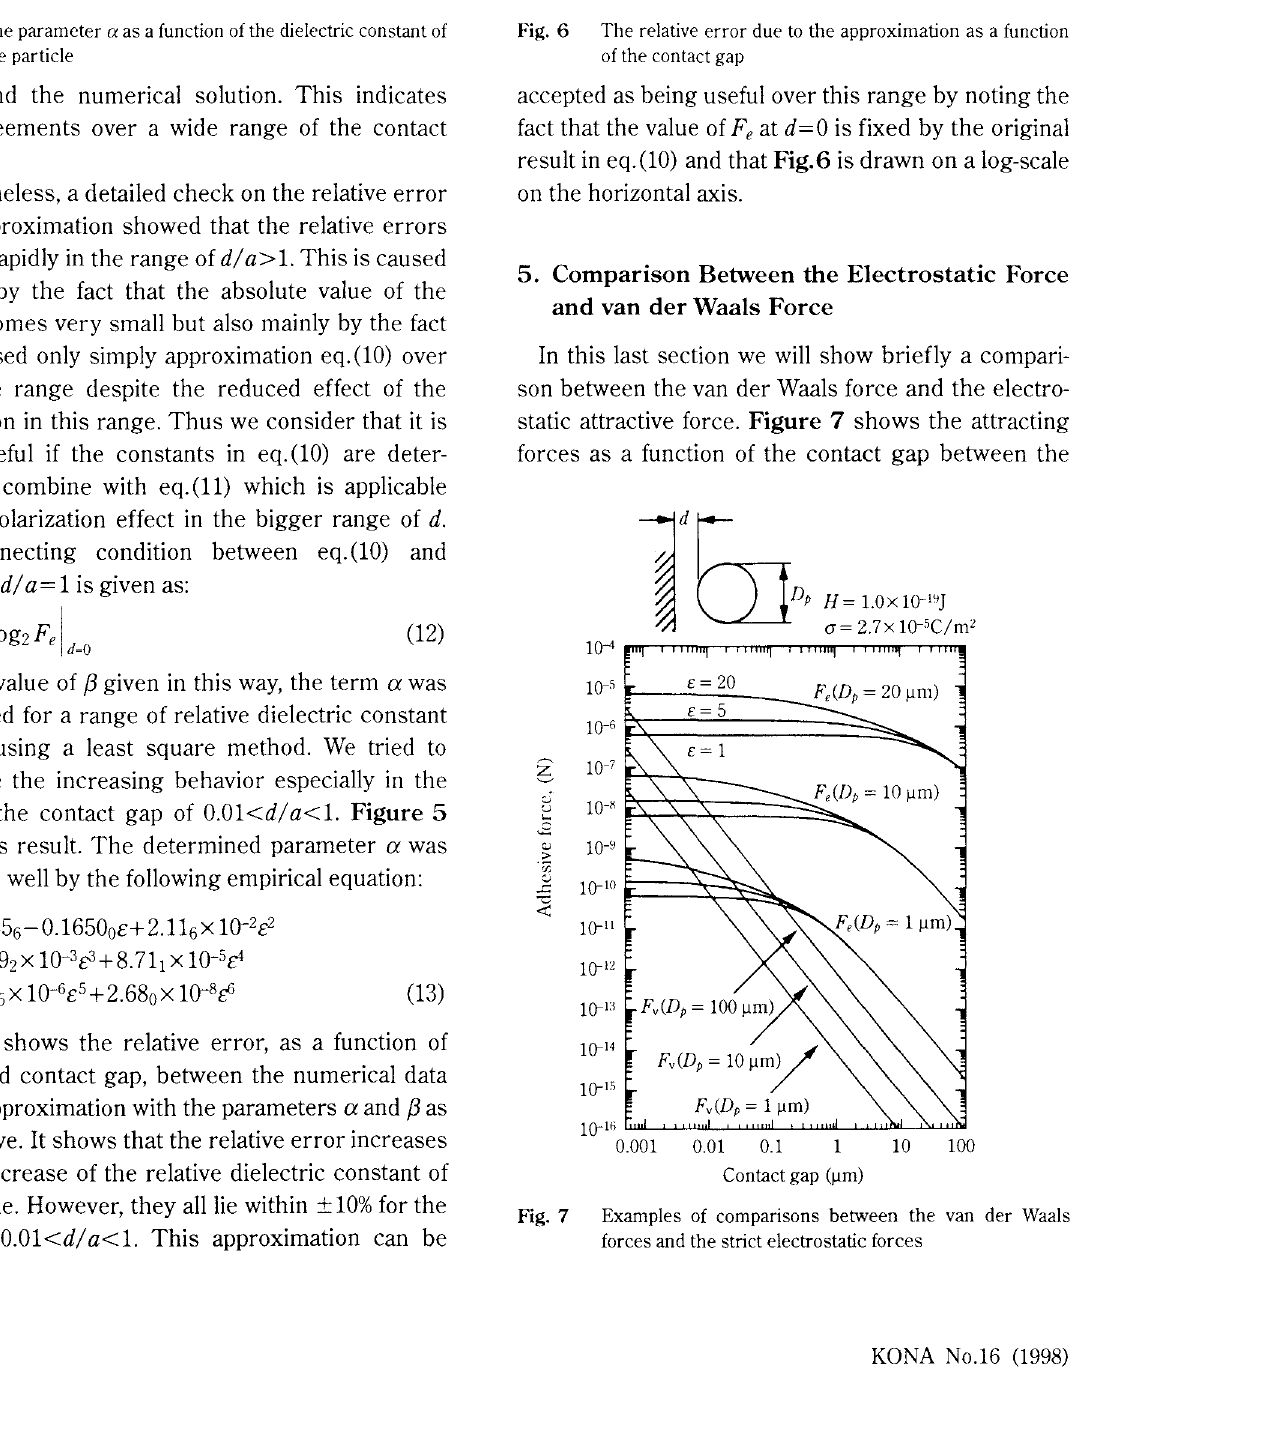
Normalized contact gap, dl a (-) Fig. 6 The relative error due to the approximation as a function of the contact gap